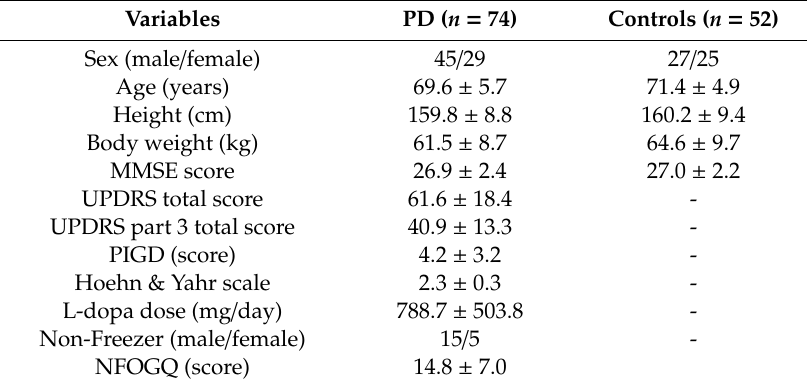
Table 1. Demographic characteristics of the study